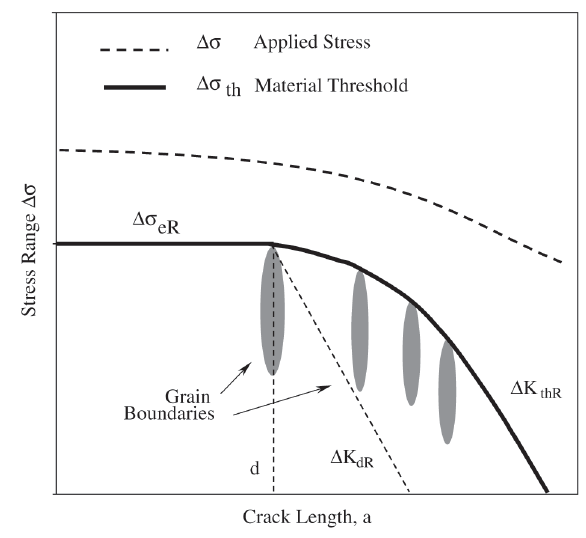
Figure 2. Schematic of the proposed material crack growth thresh- old as a function of crack